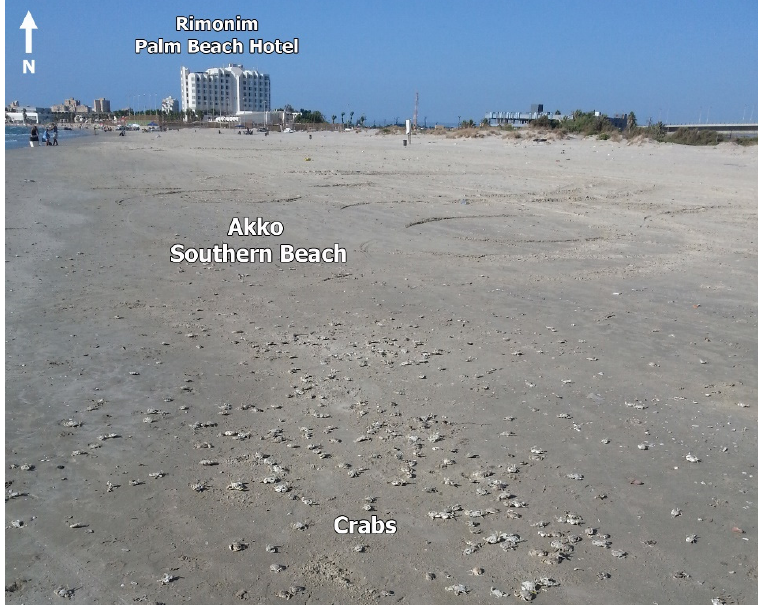
Figure 5. Large amount of discarded crabs, apparently a bycatch of intertidal fishing, Akko beach, north Haifa Bay (photographed by Gidi Bettelheim, 18 September 2015).